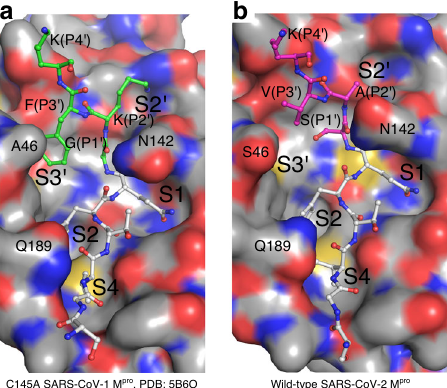
Fig. 4 Modeling of the SARS-CoV-2 M pro enzyme – substrate complex. a CPK molecular surface of SARS-CoV-1 C145A catalytic mutant ES complex (PDB 5B60), including C-terminal cleavage site P6 – P4 ′ (P1 ′ – P3 ′ with green carbons). b CPK molecular surface for the SARS-CoV-2 M pro acyl-enzyme active site. The additional residues P1 ′ – P4 ′ (magenta carbons) are modeled based on ( a ). Sequence alignment for all M pro processing sites shown in Supplementary Fig. 1b. Note the identical sequence preceding the scissile bond between SARS-CoV-1 and -2 M pro , but divergence in P1 ′ – P3 ′ (N- terminus of the subsequent nsp6). Despite these differences, the S1 ′ – S3 ′ pockets observed in the SARS-CoV-2 M pro acyl-enzyme active site are similar to that in ( a ), i.e., already preformed in the absence of P1 ′ – P3 ′ (modeled here), and apparently not dependent on the binding of P2 ′ . It is also evident from this panel that the P1 ′ – P3 ′ side chains are not sterically matched to the S1 ′ – S3 ′ pockets, perhaps an advantage in protein